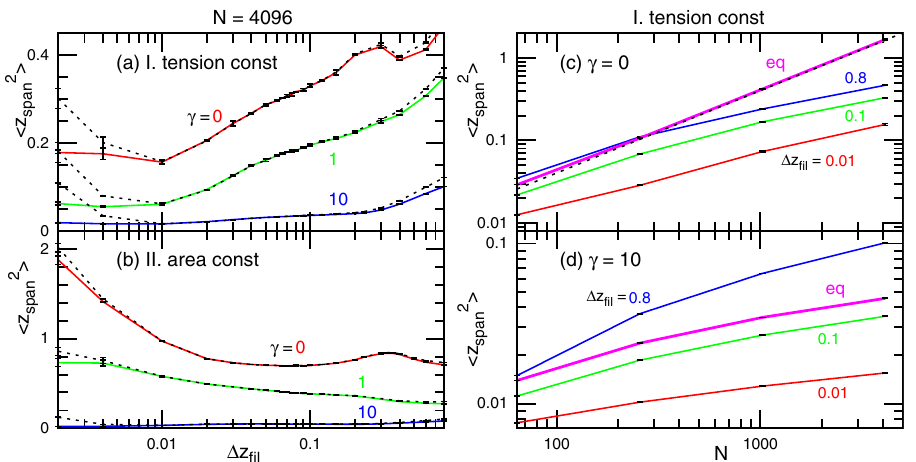
(cid:31) z fil for γ 0 , 1, = 0 and ( d ) γ 10 in case I. The thick = =